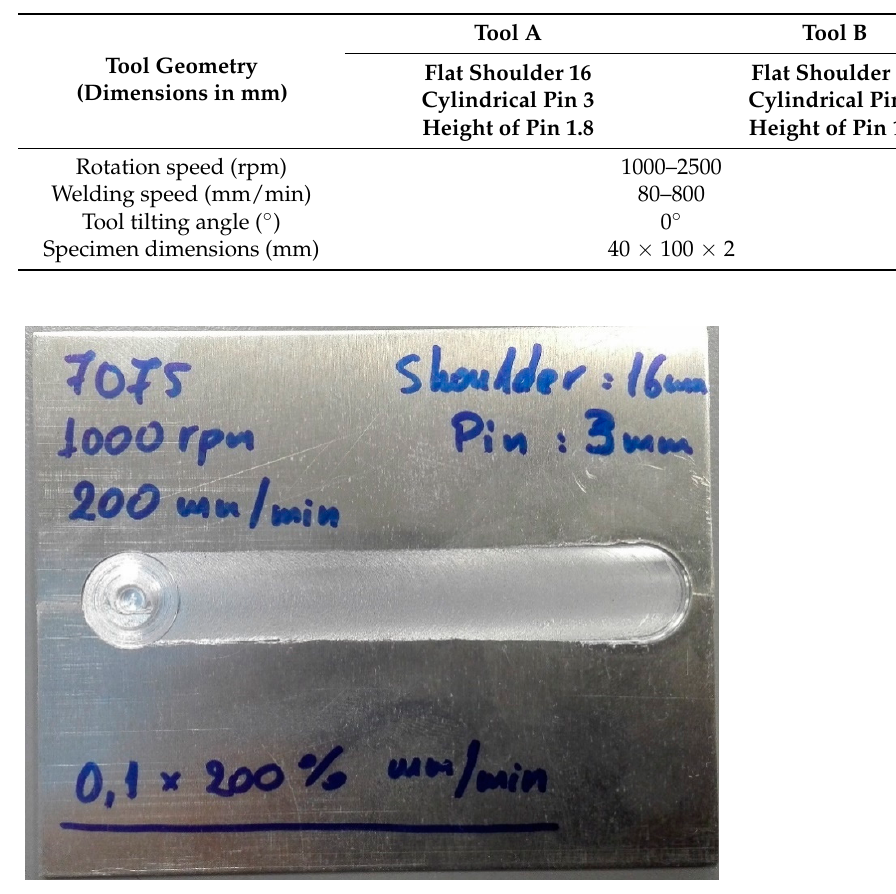
Figure 2. Typical welded specimen.